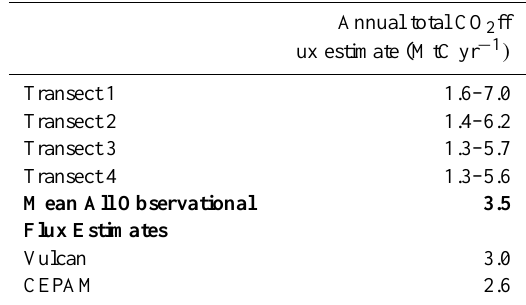
Table 3. CO 2 ff flux estimates for the Sacramento urban region from measurements made on 27 February 2009, and scaled to the annual total CO 2 ff emissions, assuming constant emissions throughout the year. Transects are the four downwind flight segments shown in Fig. 9. Flux estimates for each transect are reported as the range of values using four different wind speed and boundary layer height estimates (see text). “Mean all observations” is the mean of all 16 realizations (four transects, four estimates each) of the calculations. Two bottom-up inventory estimates of the annual total emissions from Sacramento County from Vulcan (Gurney et al., 2009) and the California Air Resources Board CEPAM database (S. de la Rue de la Can, personal communication, 2010) are included for compari-